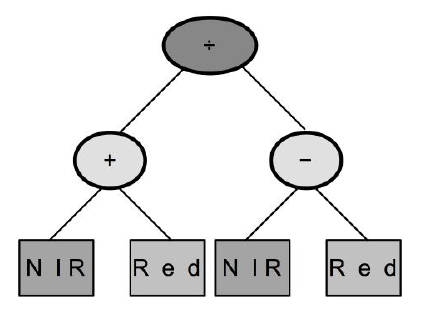
Figure 5. Syntactic tree for the